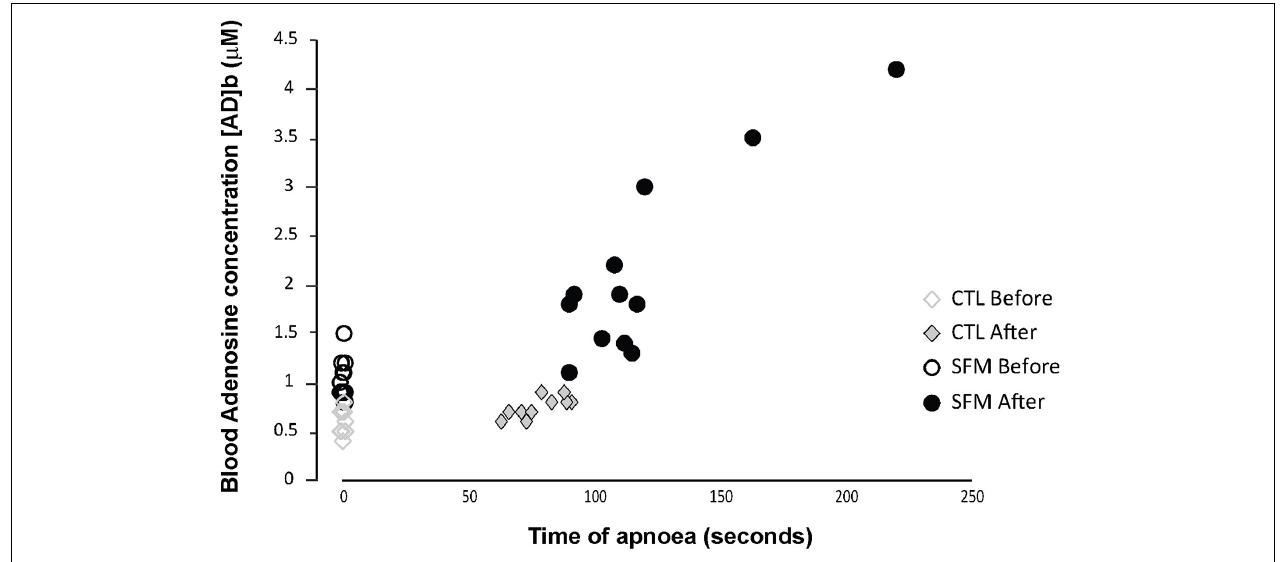
FIGURE 1 | Individual values of blood adenosine concentration measured in spearfishermen (SFM) and control (CTL) subjects before and immediately at the end of the static apnea.